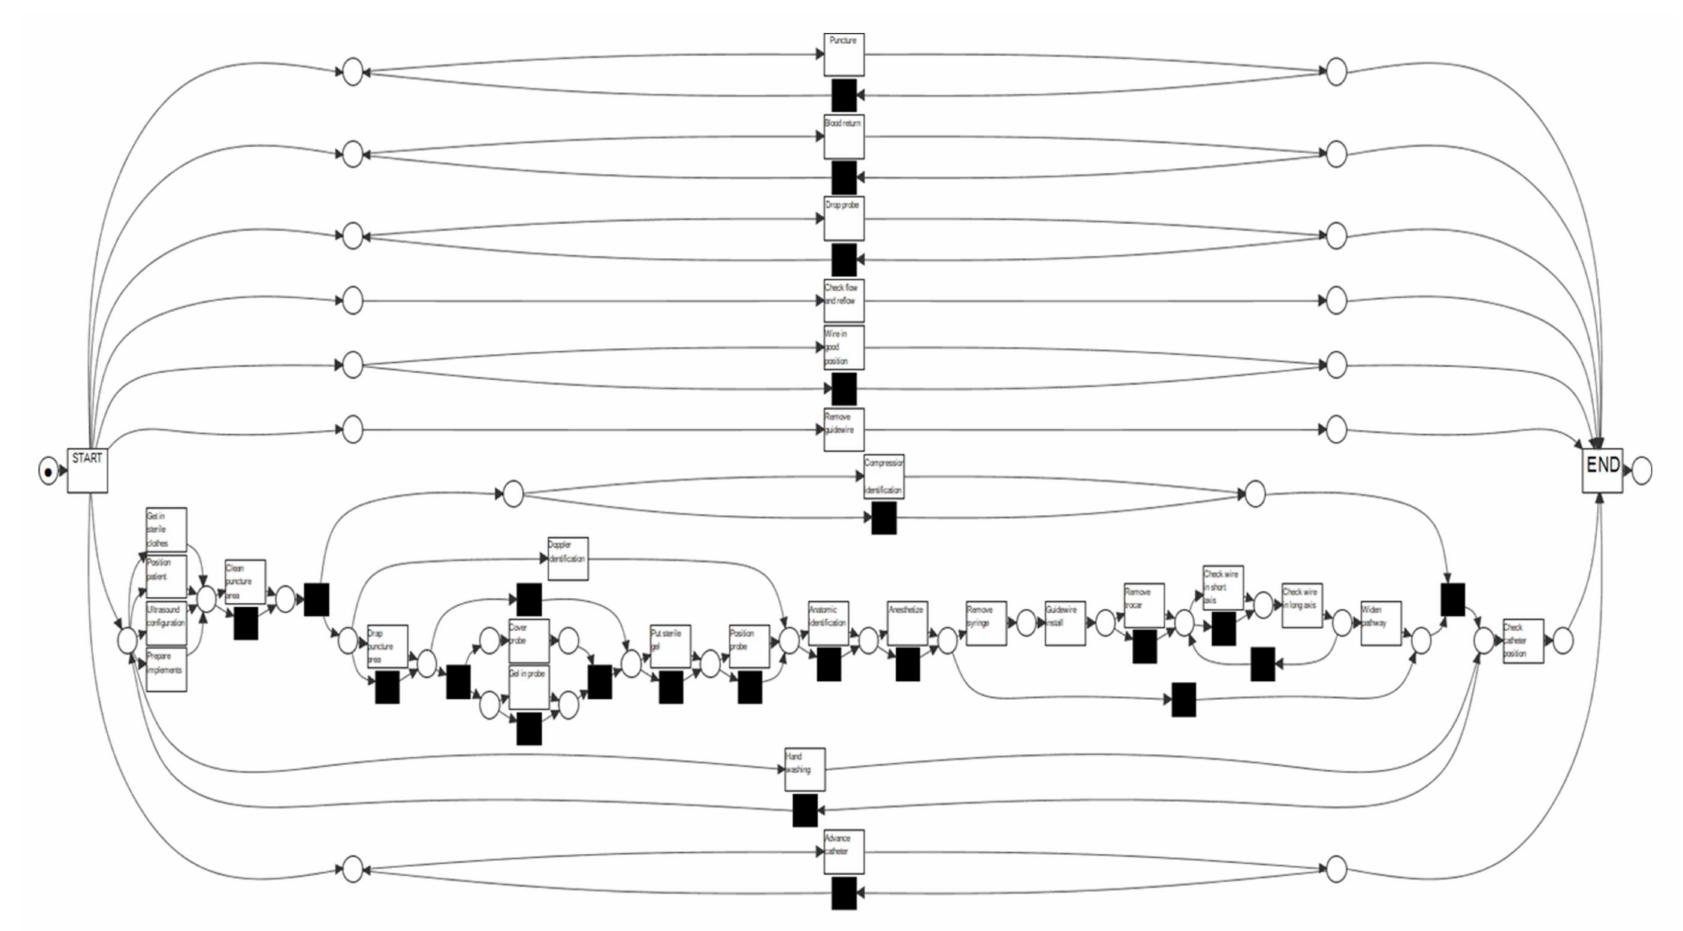
Figure 5. Process discovery with inductive